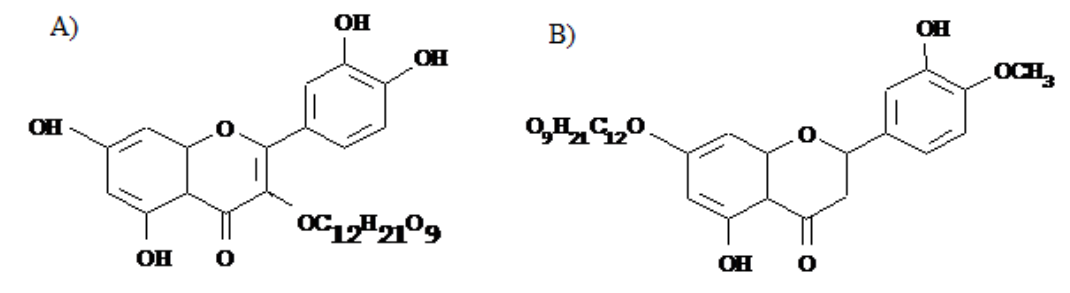
Figure 1. Structural formulae of rutin (A) and hesperidin